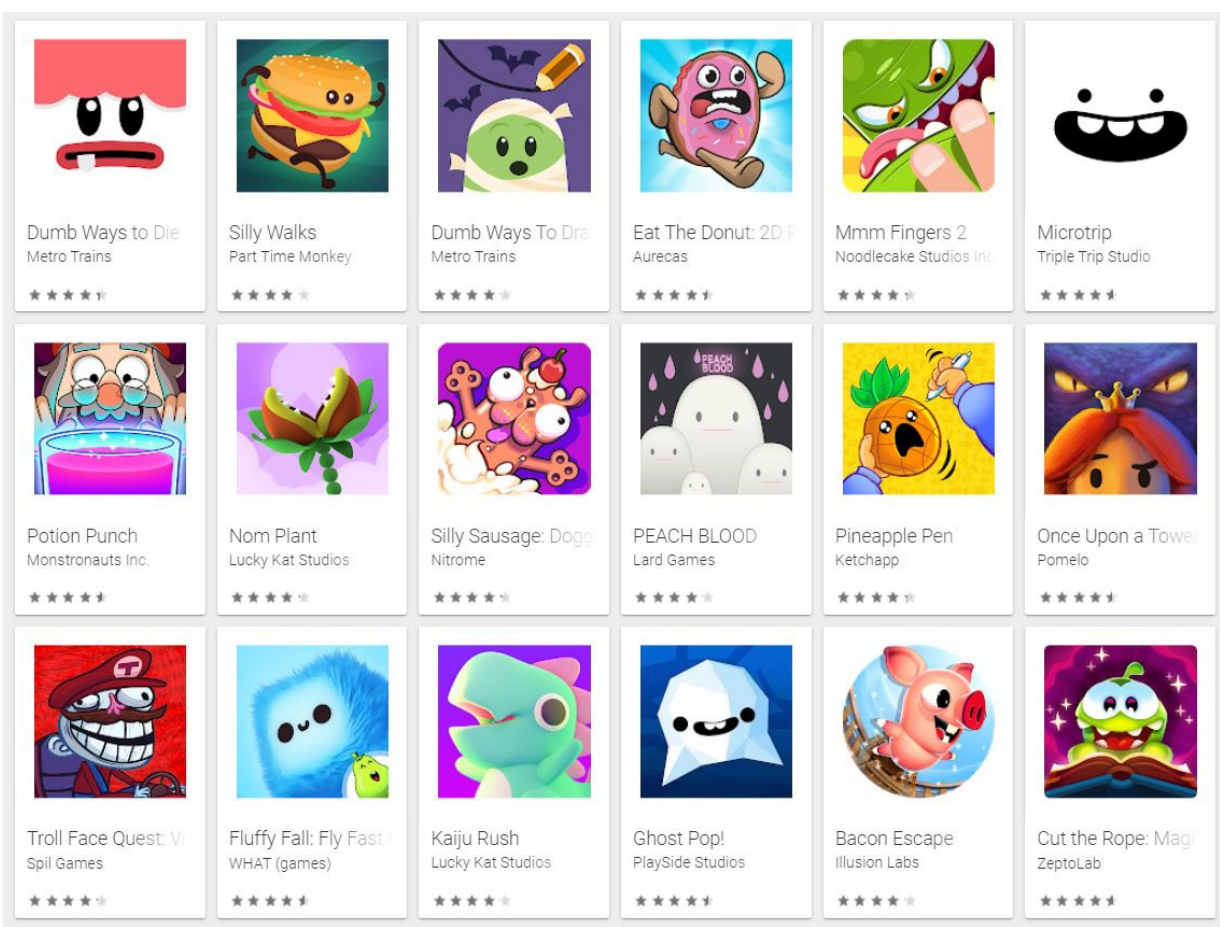
Figure 1. A screenshot of the Google Play Store: Should uninitiated users be able to tell serious games apart from enter- tainment games? Source: Google Play Store (n.d.), screenshot by